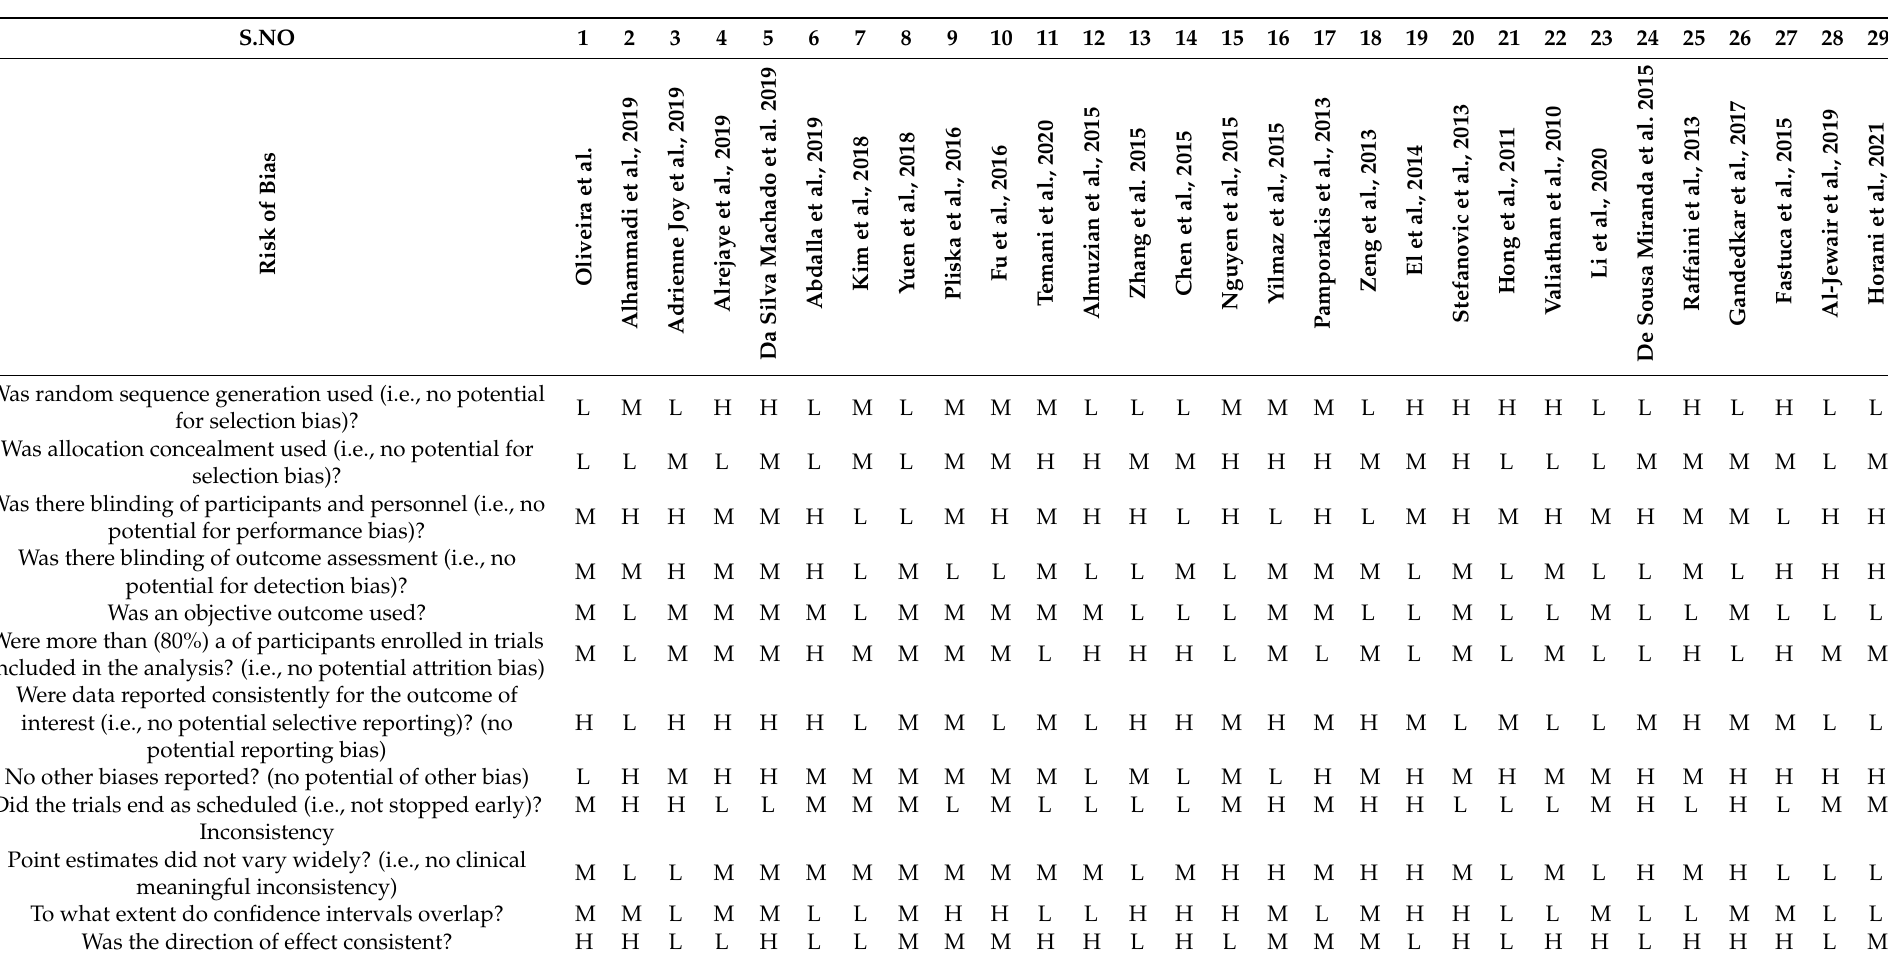
Table A2. Risk of bias assessment of the inlcuded studies. S.NO